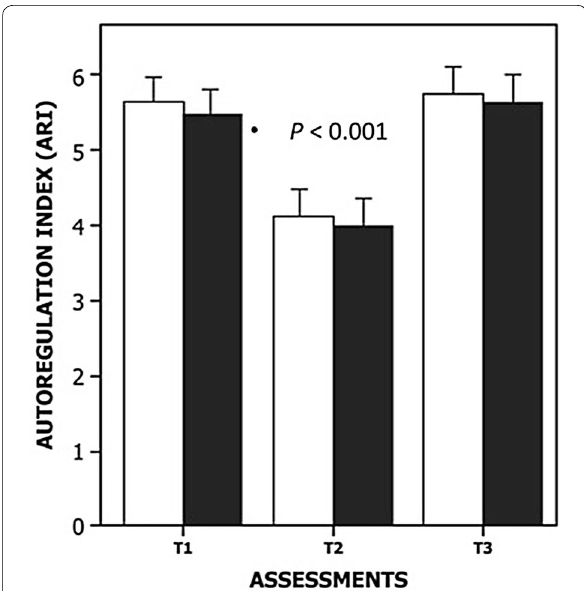
Fig. 3 Mean values ( 1 standard error) of ARI for control group ± population (white bar) and intra‑aortic balloon pump population (black bar), followed by the session number corresponding to before the surgery ( T 1), 24 h ( T 2) and 7 days ( T 3) of follow‑up